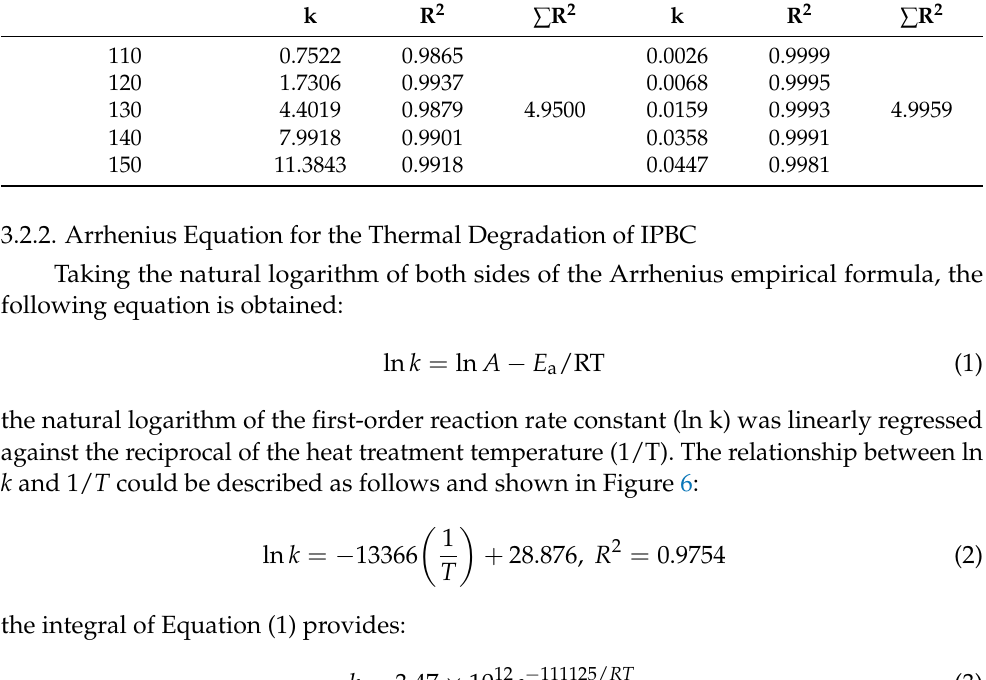
Table 2. Reaction rate constants and coefficients of IPBC during thermal degradation from 110 ◦ C to 150 ◦ C. Reaction Order Temperature ( ◦ C) Zero-Order First-Order